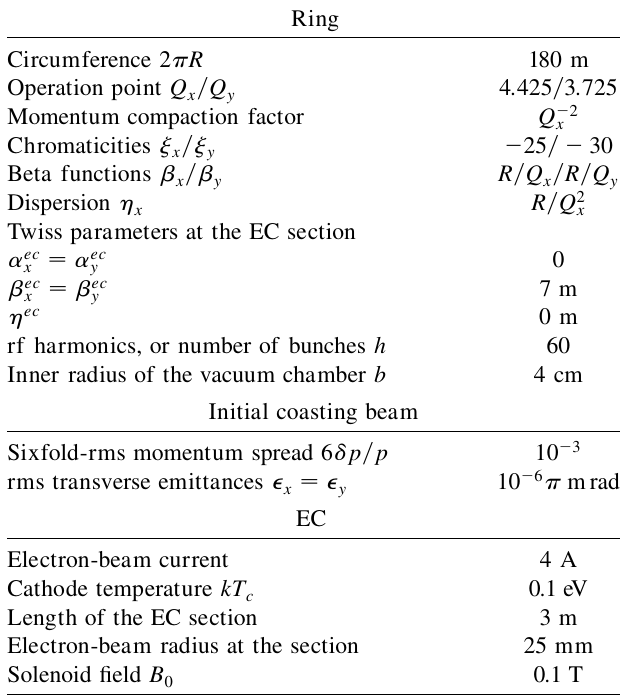
Parameters of the ring, an initial coasting beam, and